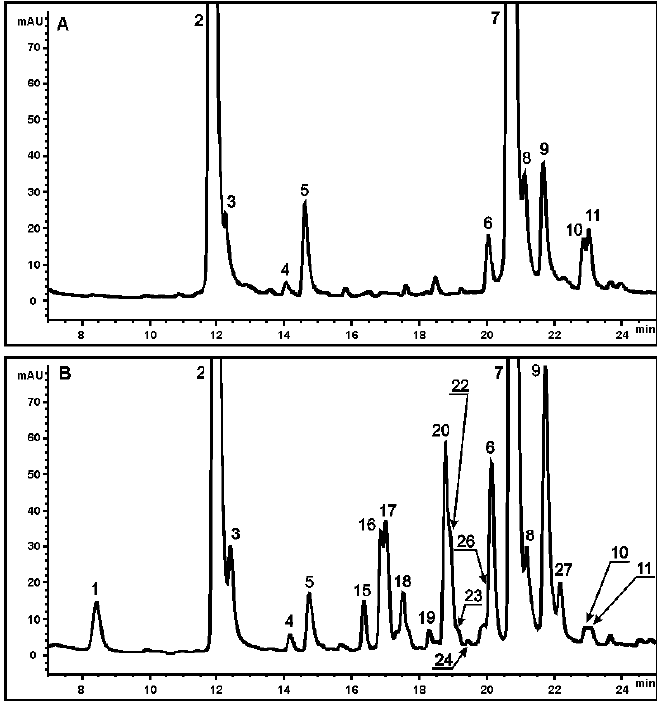
Figure 2. Representative HPLC-UV profiles of S. radiata extracts, monitored at 325 nm. ( A ) Methanolic extract of the Sr-L1 callus line; ( B ) methanolic extract of S. radiata leaves. Peak numbers correspond to each of the identified components listed in Tables 1 – 4.